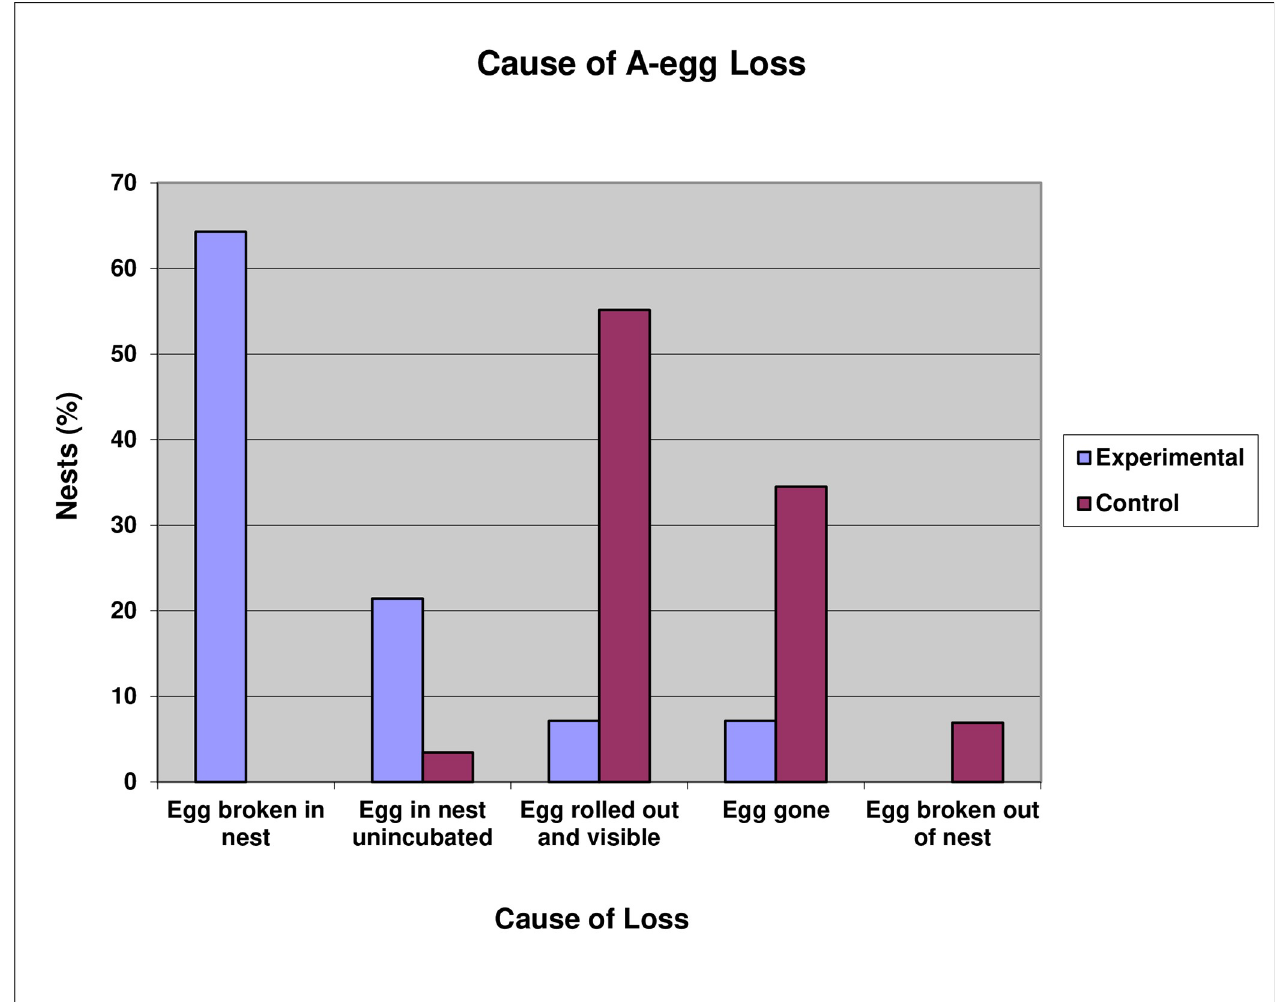
Fig 12. Causes of A-egg losses for Experimental and Control